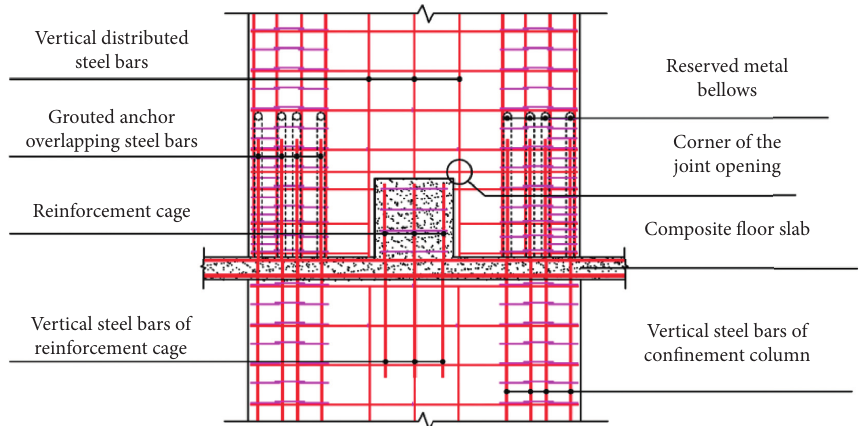
Figure 4: Reinforcement layout plan of precast shear wall with the proposed reinforced